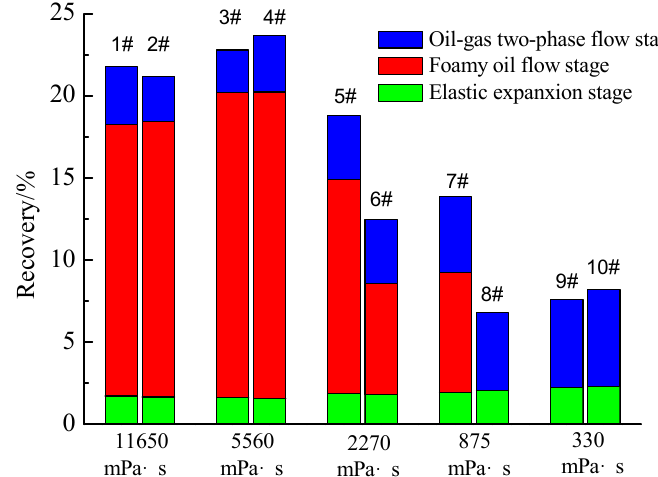
Figure 8. Effect of oil viscosity and asphaltene on the total recovery and the recovery of each stage.